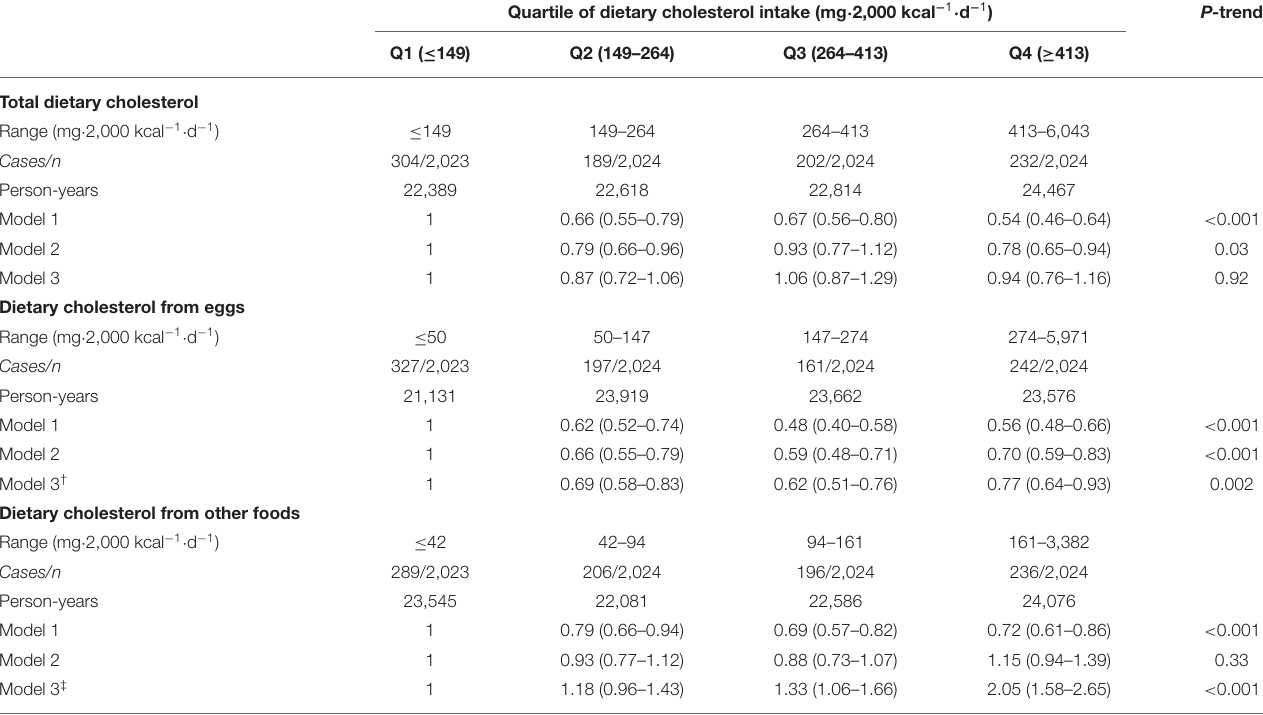
TABLE 3 | HRs (95% CIs) of the mortality among hypertensive patients according to the dietary cholesterol intake ( n = 8,095) *